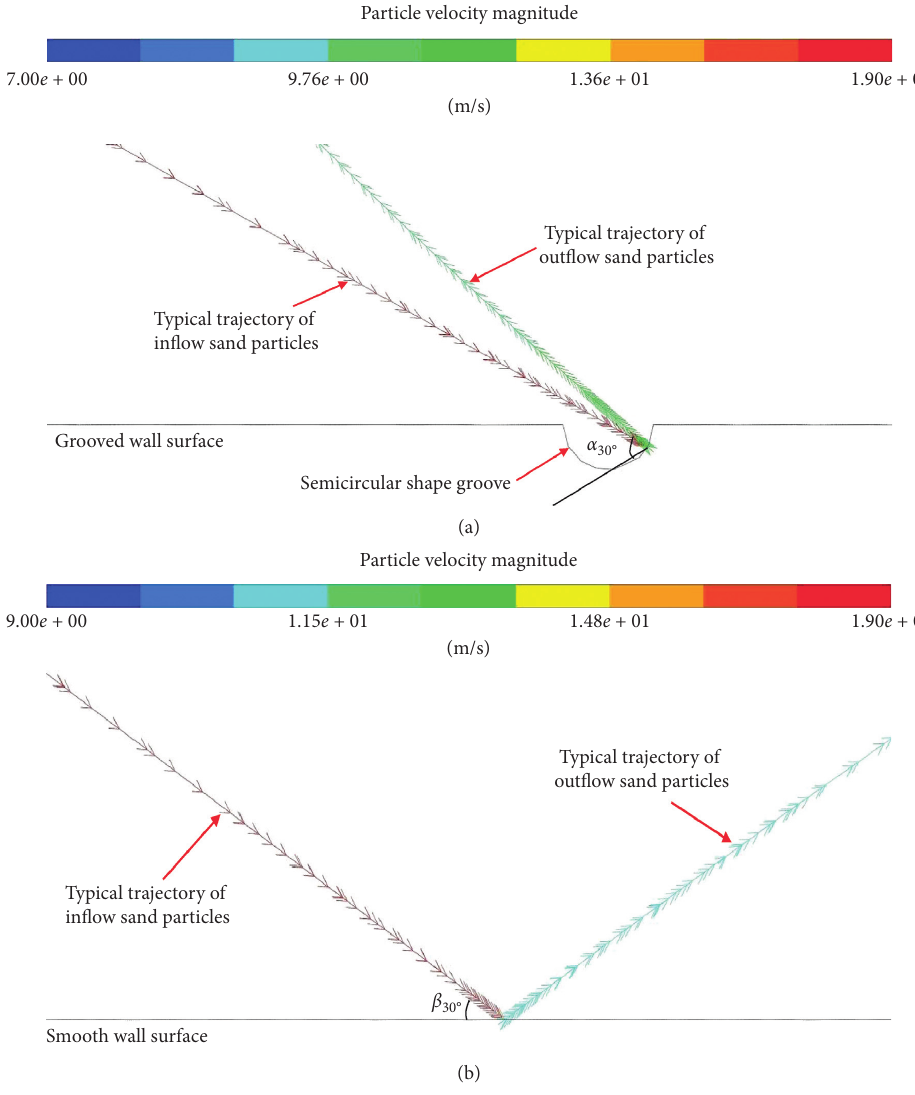
Figure 4: Typical trajectories of sand particles interaction with concrete wall surfaces at the impact angle of 30 ° and wind velocity of 19m/s: (a) grooved; (b)